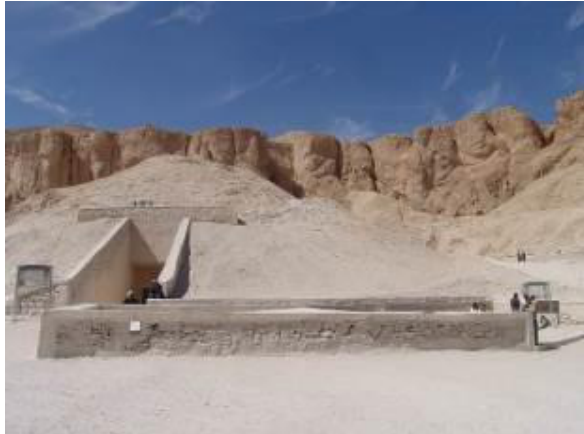
Figure 1. The entrance to the tomb of Tutankhamen, Valley of the Kings © J. Paul Getty Trust 2009